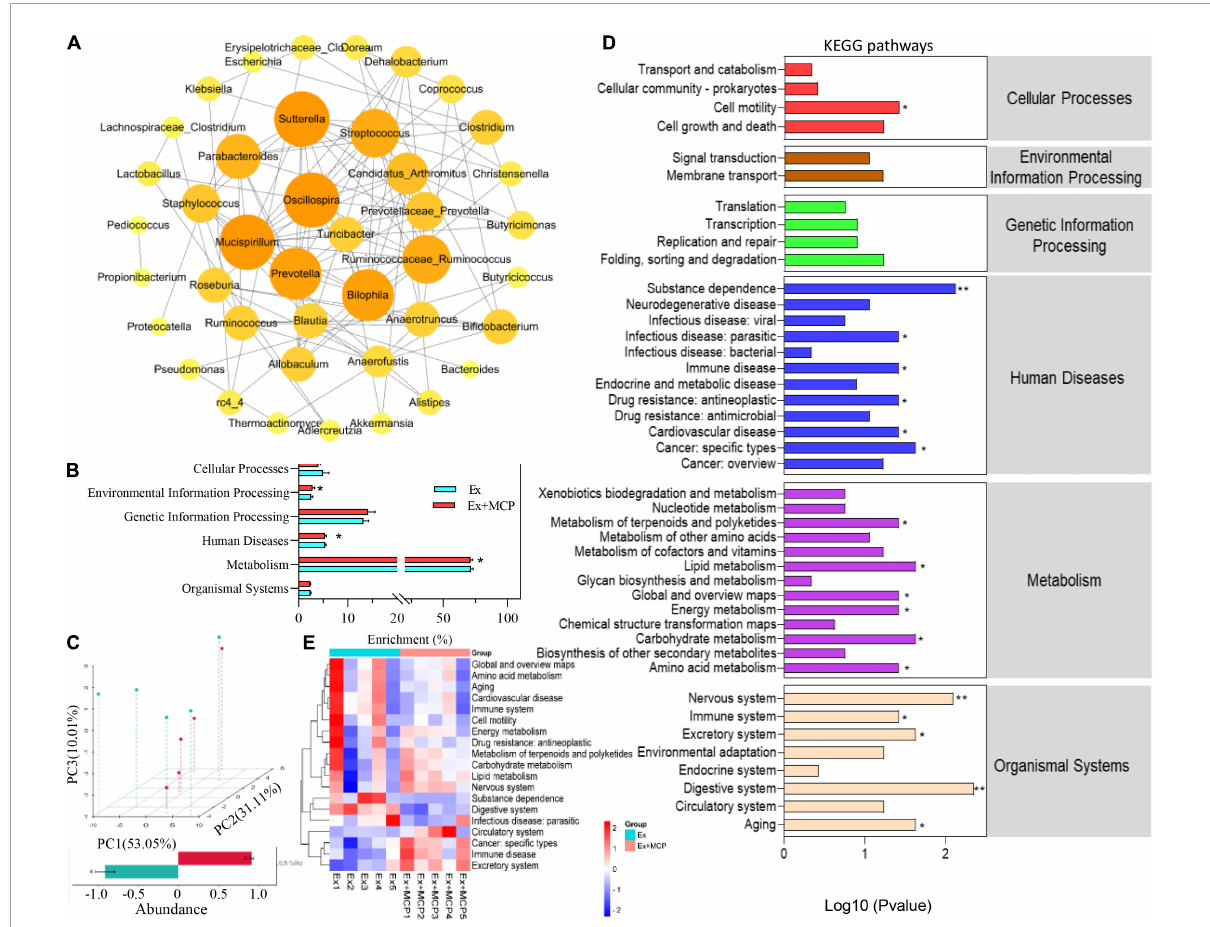
FIGURE5 Effect of Maca compound preparation (MCP) on the mice gut microbial functions. (A) Correlation networks of microbe-microbe interactions regulated by MCP. Here, the lines between the circles represents a significant correlation ( p -value < 0.05), the red represents a positive correlation, and blue represents a negative correlation. (B) Kyoto Encyclopedia of Genes and Genomes pathway (KEGG) of microbial (level 1). (C) Principal component (PCA) analysis of microbial genus levels and functional differences between Ex and Ex + MCP groups; (D) Heatmap of KEGG (level 2) pathways (adj. p -value < 0.05). (E) KEGG (level 2) pathways of the mice gut microbial gene functions related to cellular processes, environmental information processing, genetic information processing, human diseases, metabolism, and organismal systems. ** p <